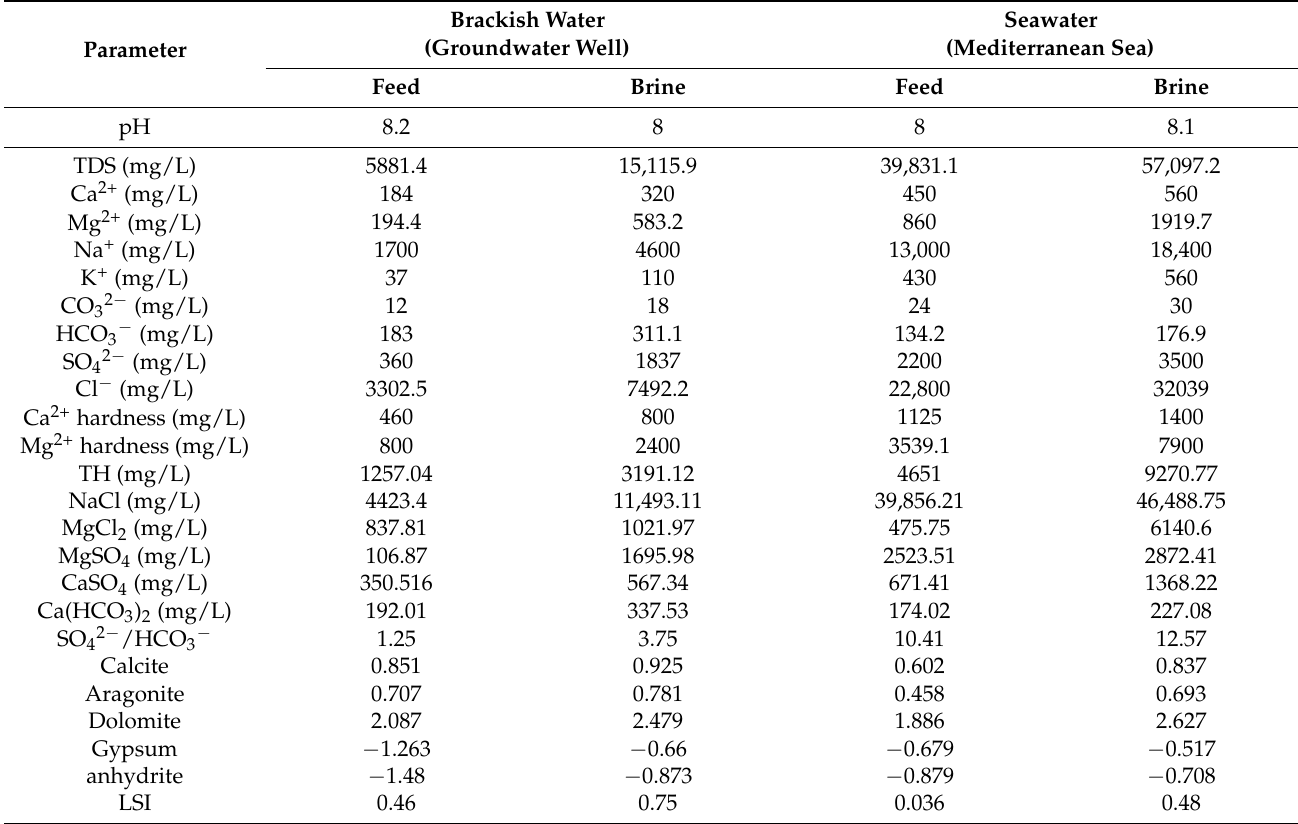
Table 2. Chemical characterization of the RO feeds and brines from two desalination plants: Shammas (brackish water) and El-Remela (Seawater), Matrouh governorate,